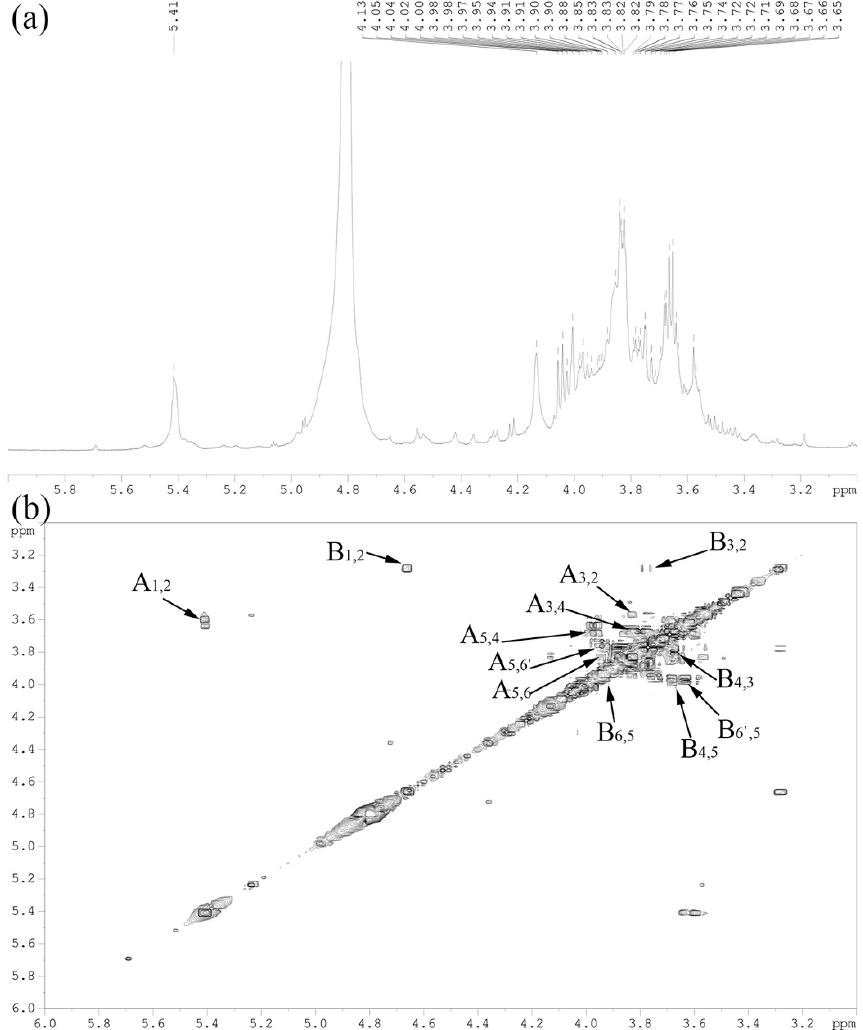
Figure 3. The 1D 1 H ( a ) and 2D COSY ( b ) spectra of DOPs (solvent: D 2 O). Table 1. Chemical shifts of C 1 ~C 6 and H 1 ~H 6 in monomers of